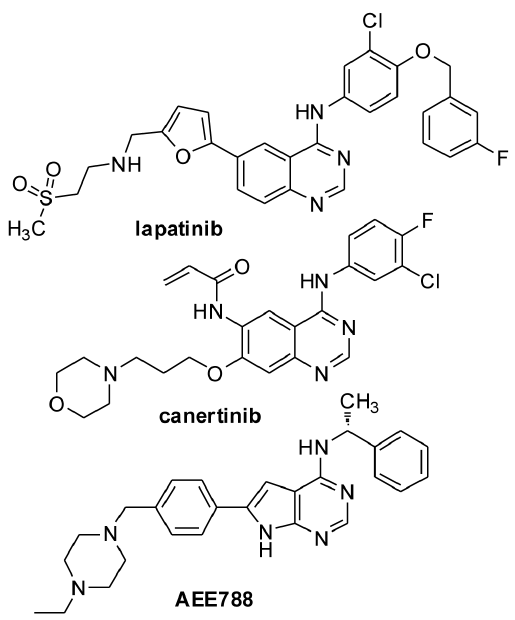
Figure 1. Chemical structure of lapatinib, AEE788, and